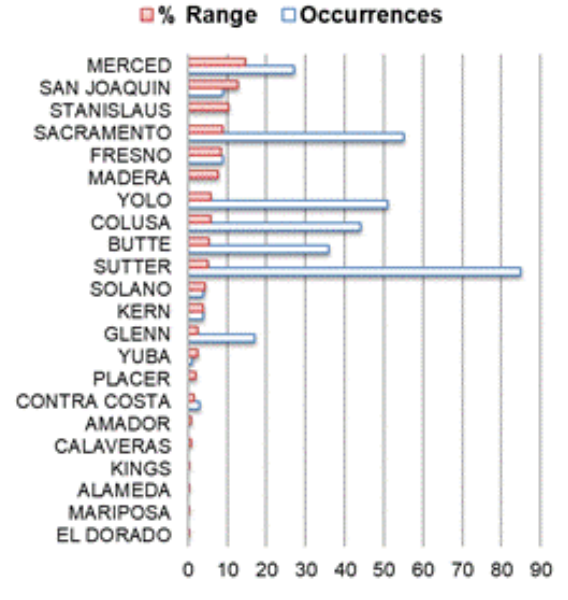
Fig. 3 . Counties are listed in rank order (high to low) of the percent of giant garter snake ( Thamnophis gigas ) geographic range contained within each county (red bars). The number of known occurrences in each county are also shown (white bars). Note that Stanislaus and Madera counties have no known occurrences despite possessing (containing) a significant amount of range.